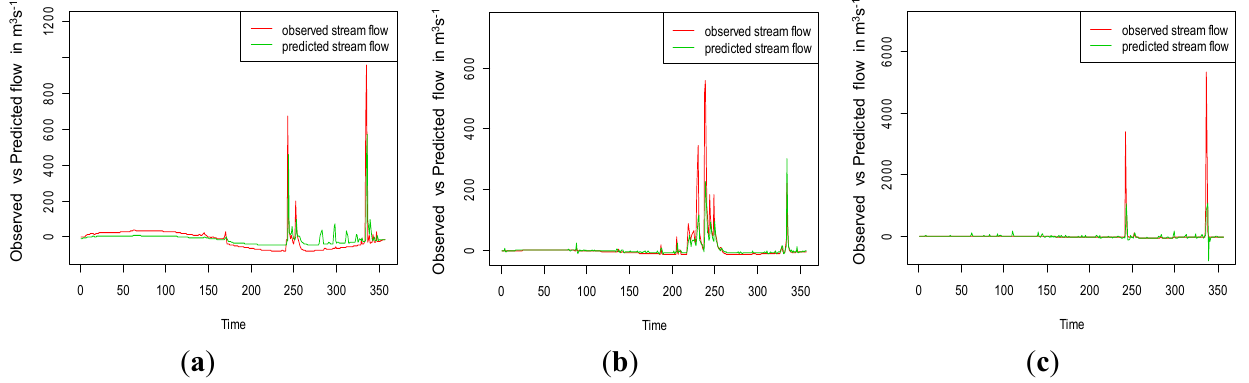
Figure 7. Observed and predicted stream flow for ( a ) Broughton River; ( b ) Torrance River; and ( c ) Wakefield River for the year